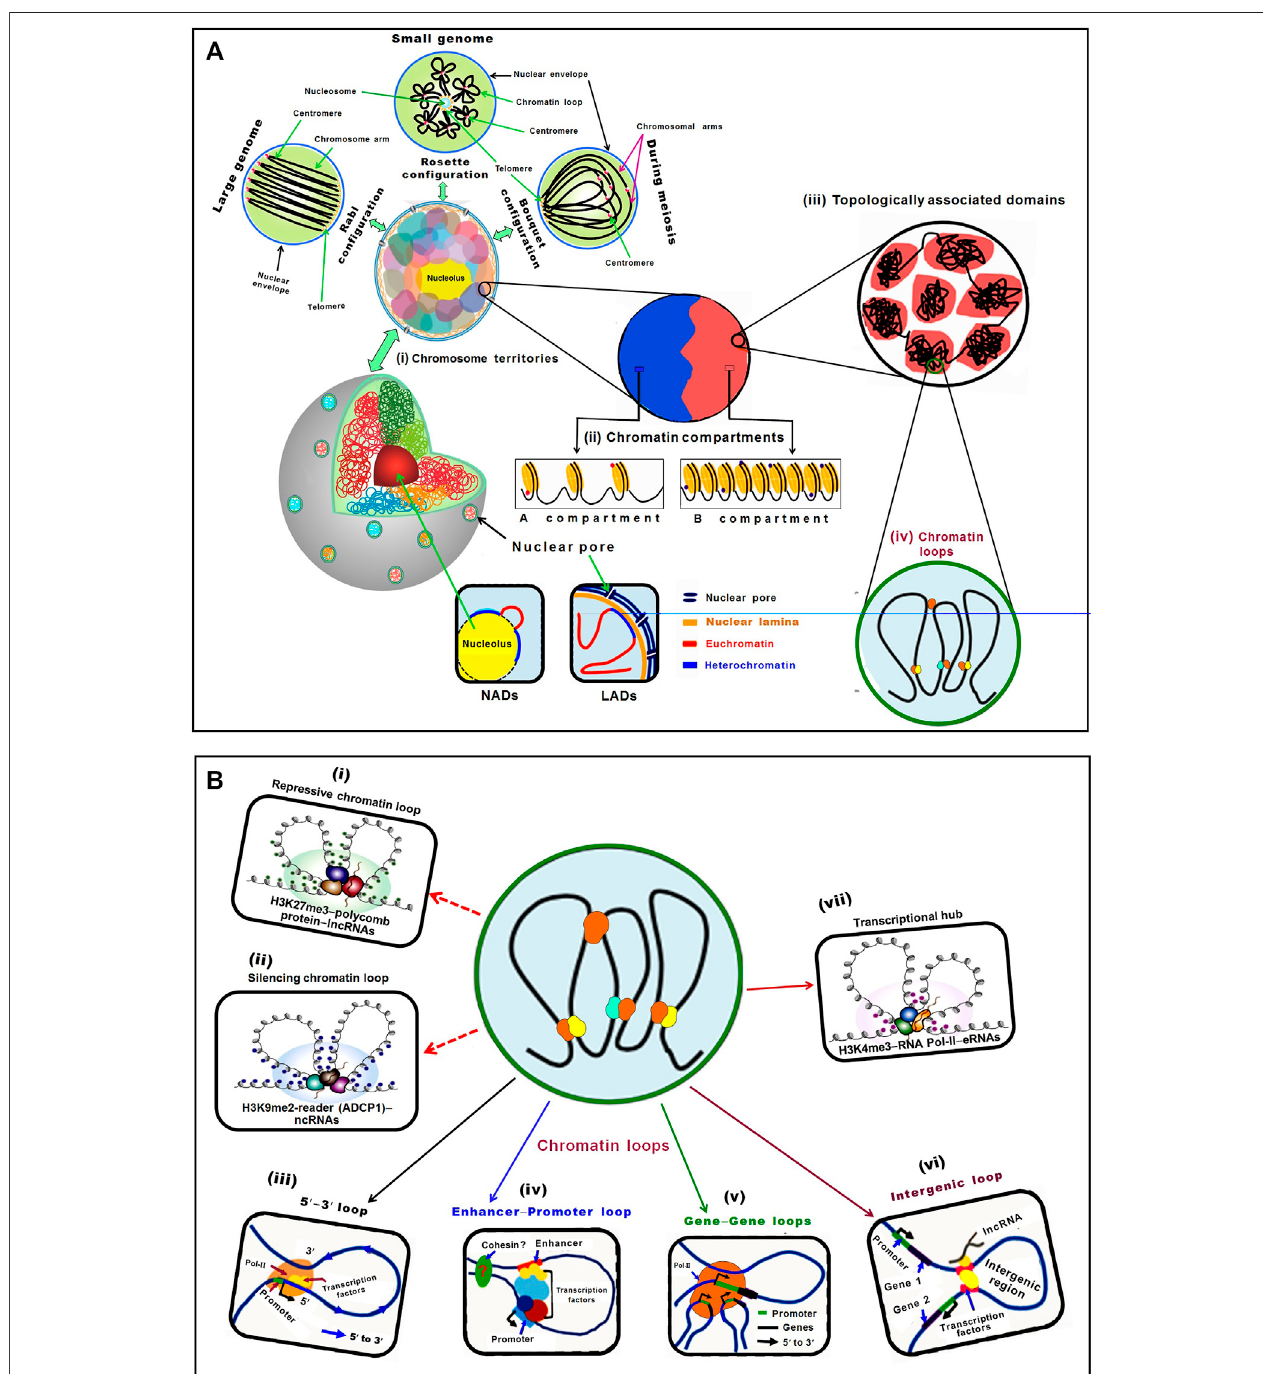
FIGURE 1 | Schematic representation of plant chromatin organization in the nucleus. (A) Hierarchical chromatin organization can be studied mainly at four levels: chromosome territory, chromatin compartments, topologically associating domain (TAD), and chromatin loops. (i) Chromosomes occupy speci fi c territories in the nucleus. In different territories, chromosomes show different morphology, such as Rabl, Rosette, and Bouquet con fi guration. In Rabl con fi guration, telomeres and centromeres of chromosomes cluster at two different poles in the nucleus, particularly in plants with larger genomes. In the Rosette con fi guration, the nucleolus is surrounded by telomeres, while heterochromatin and centromeres are clustered together but euchromatin oozes out freely in the nucleus to form a rosette-like con fi guration, observedinplants withsmaller genomelikeArabidopsis.Bouquetcon fi gurationisatransientchromatin con fi guration observed duringmeiosis indifferent organisms, including plants, wherein telomeres of the chromosomes are co-localized on a speci fi c site of nuclear periphery, while the rest of the chromatin remains dispersed in the nuclear space. Nucleolus-associated domains (NADs) are chromatin regions that interact with the nucleolus, while the lamina-associated domains